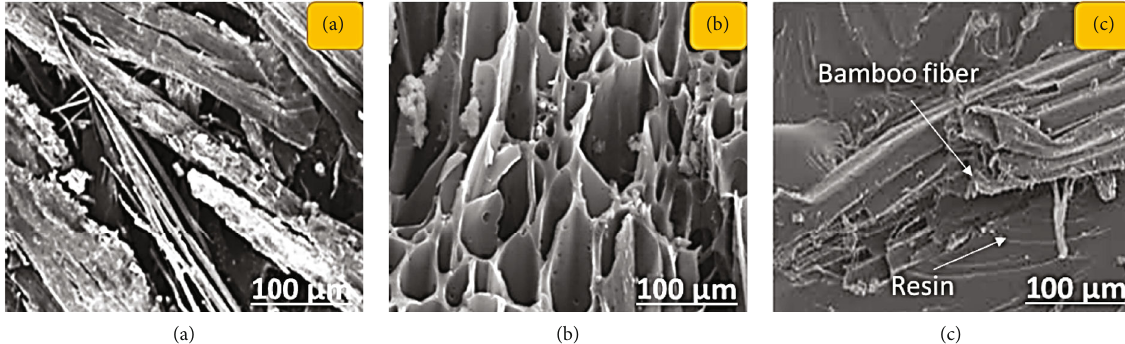
Figure 1: SEM image of (a) bamboo fi ber and (b) resin-hardener and (c) distribution of the bamboo fi ber in the matrix.